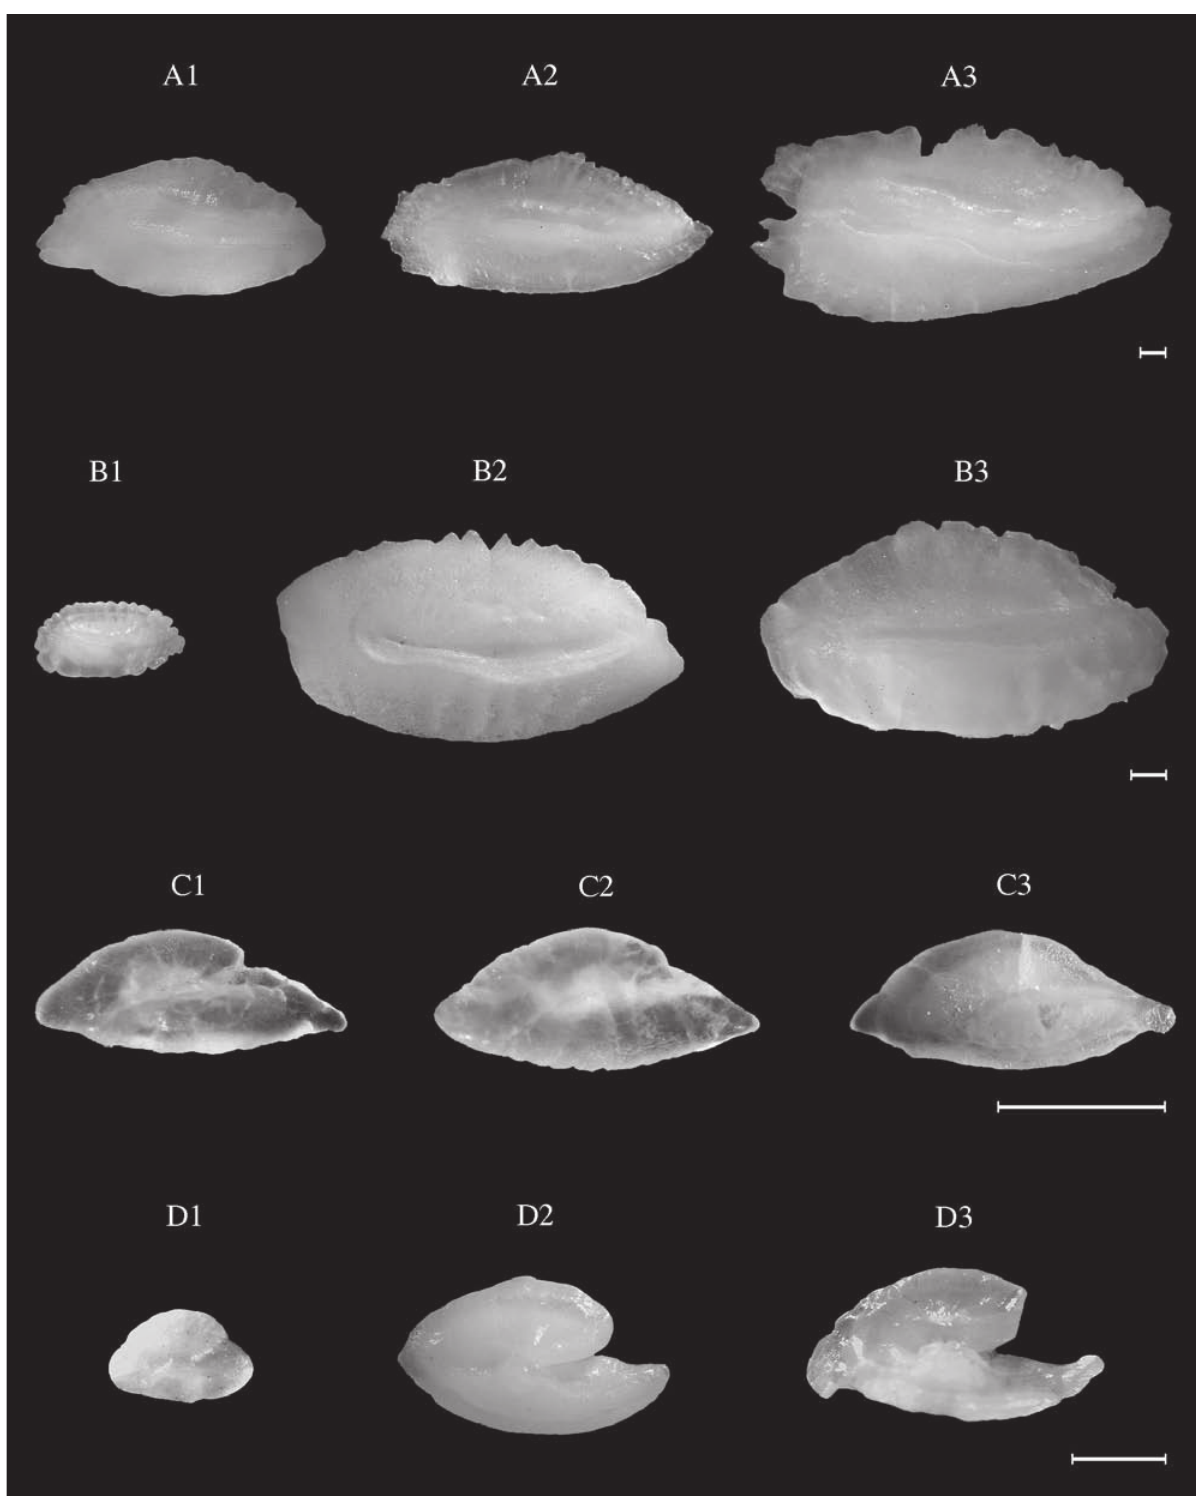
Fig. 75. – Trachinus radiatus . TL: A1, 28.0 cm (WM); A2, 35.5 cm (CEA); A3, 47.0 cm (CEA). Uranoscopus scaber . TL: B1, 9.5 cm (WM); B2, 28.1 cm (NEA); B3, 28.2 cm (CEA). Tripterygion delaisi . TL: C1, no available (WM); C2, no available (WM); C3, 4.5 cm (CEA). Blennius ocellaris. TL: D1, 5.5 cm (WM); D2, 12.5 cm (NEA); D3, 16.0 cm (WM). Scale bar = 1